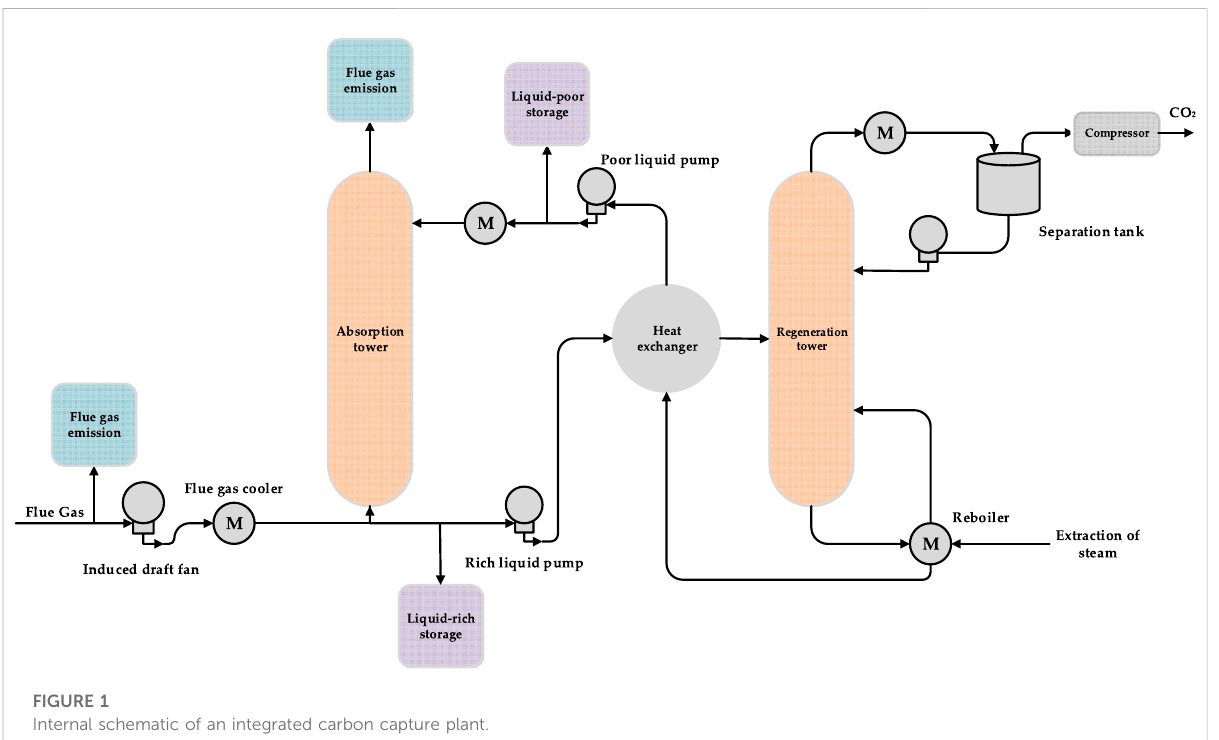
FIGURE 1 Internal schematic of an integrated carbon capture